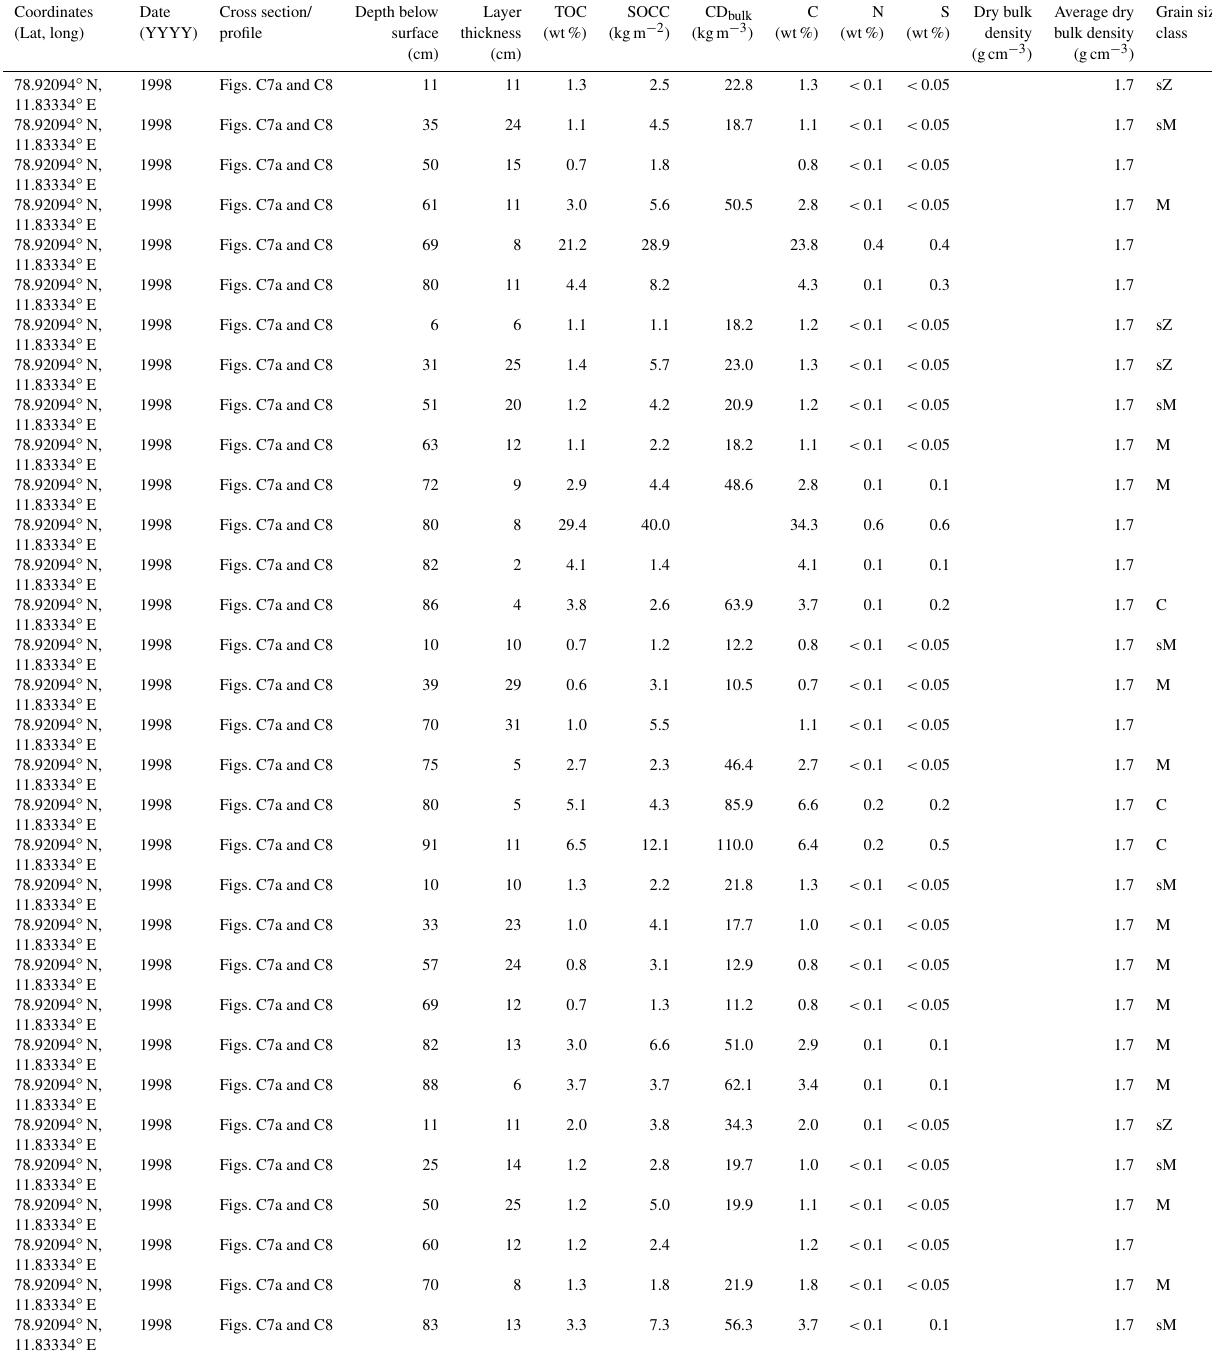
Table F1. Soil data from the soil pits in 1998, 2007 and 2009. The location of the soil profiles (including pictures and location) is given in Appendix C and Fig. 2a. Grain size class according to Folk (1954): S, sand; s, sandy; Z, silt; z, silty; M, mud; m, muddy; C, clay; c, clayey. In 2009 at depths of 30 and 35cm, high total organic content (TOC), soil organic carbon content (SOCC), bulk carbon density (CD bulk ) and carbon (C) values possible due to natural coal in the soil profile.